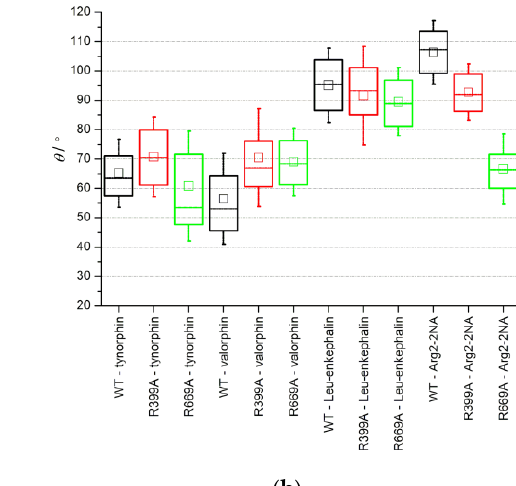
group and the peptide C-terminus or the carbonyl group at the P3 ’ position, respectively.